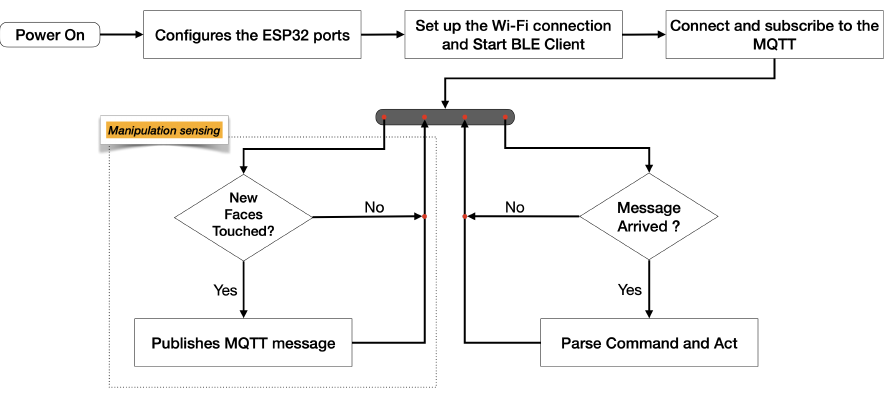
Figure 9. TactCube firmware